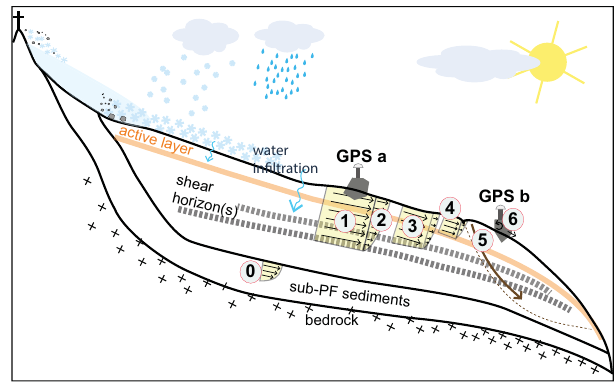
Figure 1. Schematic profile of a rock glacier. The observed move- ment at the surface might result from movement at different depths of the rock glacier (Roer et al., 2008): (0) deformation of sub- permafrost sediments (Roer et al., 2008); (1) displacement within main shear horizon (see, e.g., Arenson et al., 2002); (2) (a little) in- ternal deformation above shear horizon (see, e.g., Arenson et al., 2002); (3) displacement within additional shear horizon(s) (see, e.g., Delaloye et al., 2013); (4) displacement at base or within the active layer (AL) (see, e.g., Buchli et al., 2013); (5) displacement due to rotational slide (see, e.g., Roer et al., 2008); and/or (6) dis- placement or rotation of boulder at surface (Lambiel and Delaloye, 2004). Thick dashed lines within the rock glacier body indicate po- tential shear